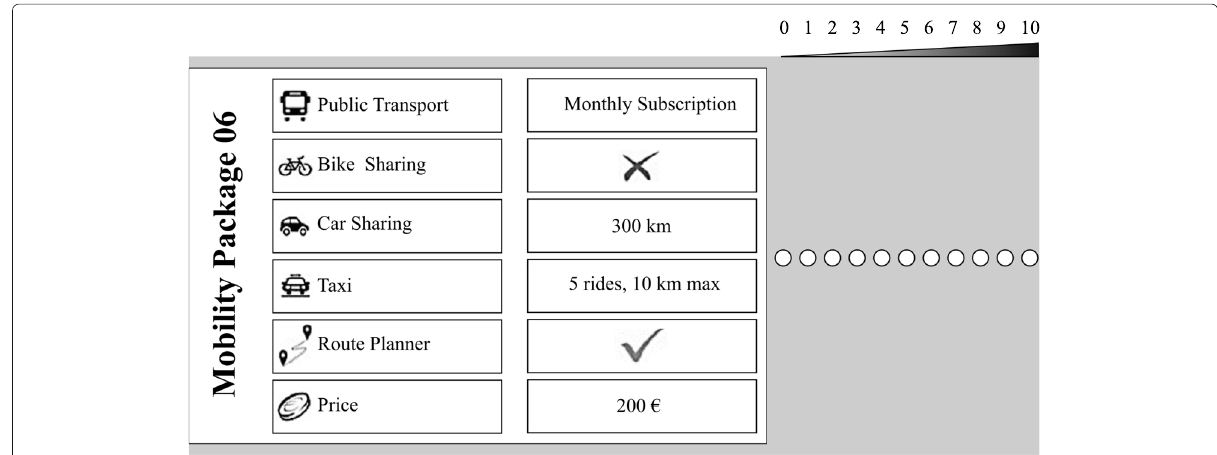
Fig. 2 Example of a mobility package in the